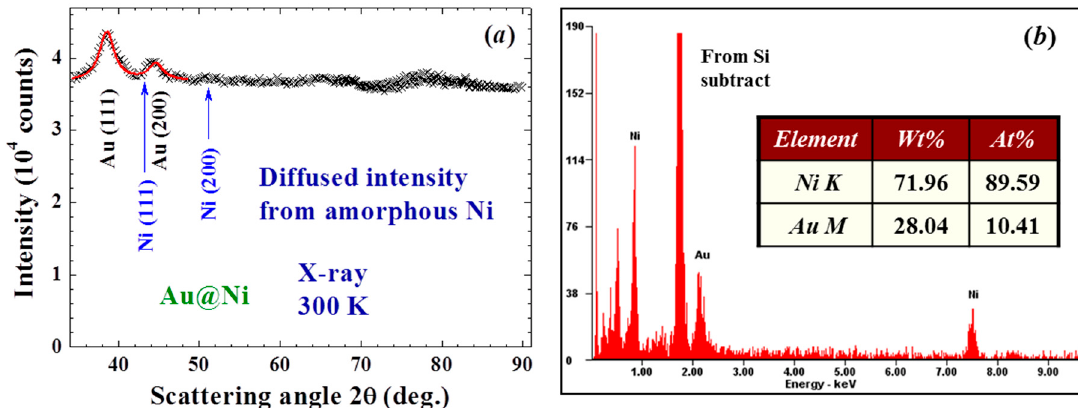
Figure 11. ( a ) X-ray diffraction pattern of the Au/Ni nanoparticles taken at room temperature, revealing a series of diffraction peaks associated with face-centered cubic Au. The solid curves indicate the calculated profiles for 5 nm Au. The arrows indicate the expected positions for face-centered cubic Ni; ( b ) a representative EDXS spectrum, where signals from Ni are dominating to reveal an atomic ratio of Ni:Au = 89.6:10.4 for this spatial region of the assembly.